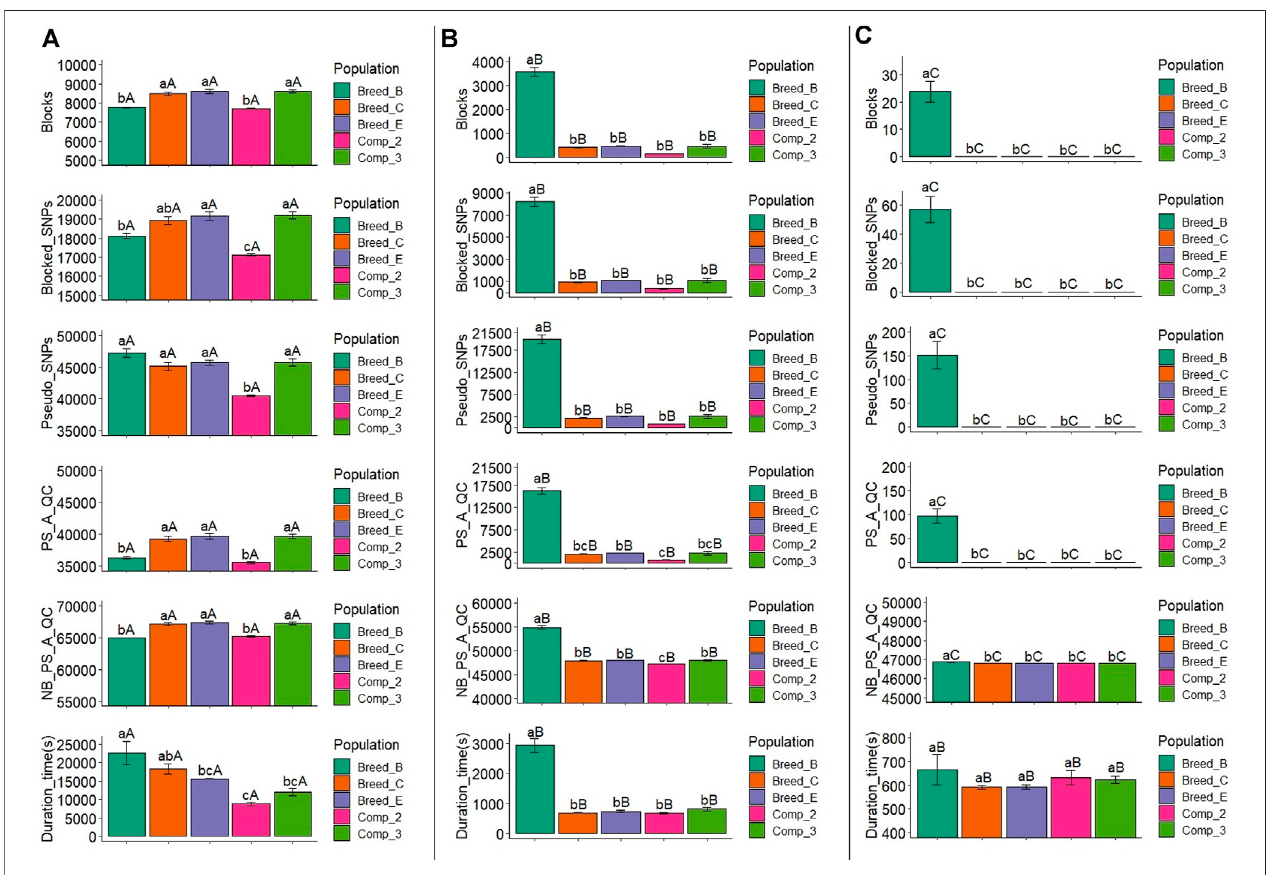
FIGURE 3 | Average number of blocks (Blocks) spanning two or more SNPs, markers within blocks (Blocked_SNPs), pseudo-SNPs (Pseudo_SNPs), pseudo- SNPs after quality control (PS_A_QC), non-blocked SNPs plus pseudo-SNPs after quality control (NB_PS_A_QC), and computing time to obtain the pseudo-SNPs (Duration_time)inthesimulation foratraitwithmoderateheritability(h 2 (cid:3) 0.30).A,B,andCshow theresultsforhaplotype blockswithLDthresholdsof0.1,0.3,and0.6, respectively.Breed_B,Breed_C,andBreed_E:simulatedpurebreedswithdifferentgeneticbackgrounds;Comp_2andComp_3:compositebreedsfromtwoand three pure breeds, respectively. The same lower- or upper-case letters mean no statistical difference comparing populations within LD thresholds and LD threshold across populations, respectively, at 5% signi fi cance level by the Tukey test.